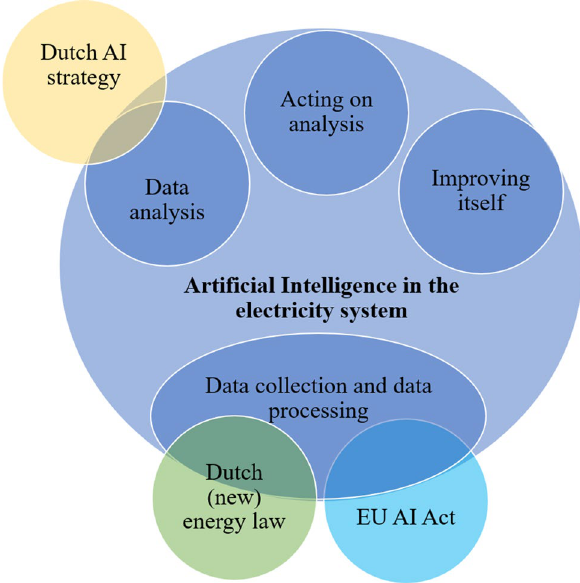
Fig. 2 Overlap between the Dutch AI strategy and the prospective Dutch energy law and EU AI Act concerning the development and use of AI in the electricity system. Data collection and data process- ing are clustered, as this